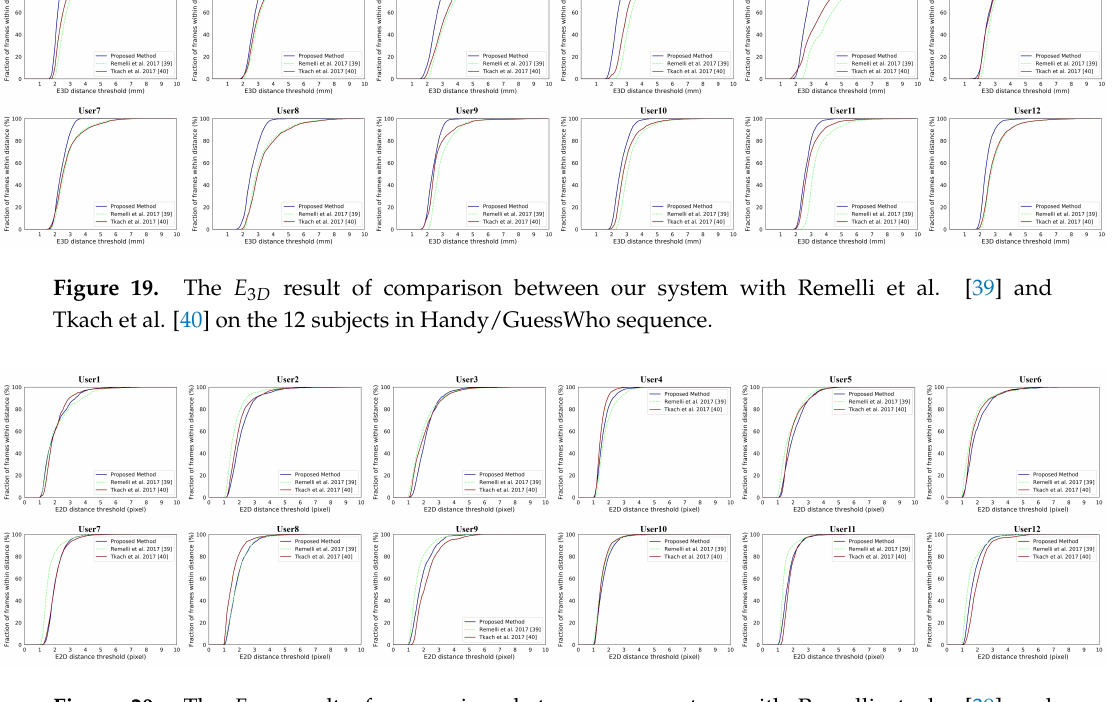
Figure 20. The E 2 D result of comparison between our system with Remelli et al. [39] and Tkach et al. [40] on the 12 subjects in Handy/GuessWho